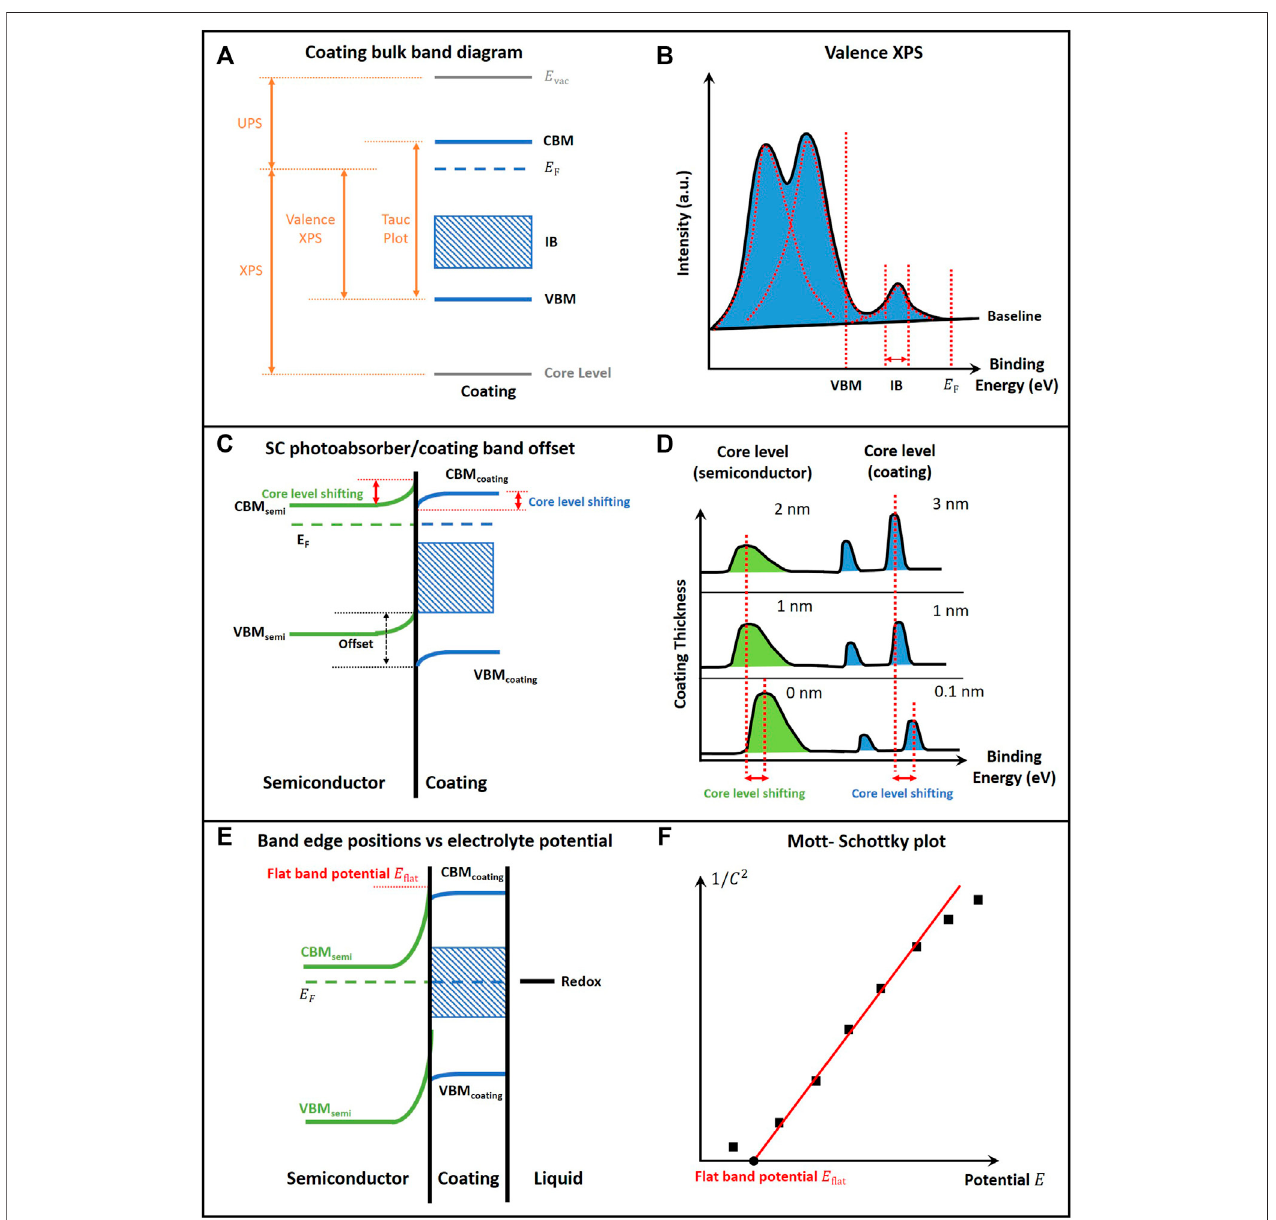
FIGURE 2 | The development of band-energy diagram of semiconductor photoabsorber/coating/(catalyst)/liquid electrolyte. (A) Band-energy diagram for bulk coating; (B) Valence XPS data with peak deconvolution results; (C) Band-energy diagram for semiconductor photoabsorber/coating integrace, which can be obtained from literature report, and the measured position ofthe peak from XPS at the interface (as indicated bythe red arrow); (D) The characteristic XPS core level peak shifting for the semiconductor and the coating; (E) Band-energy diagram for semiconductor photo absorber/coating/(catalyst)/liquid; (F) Mott-Schottky plot, i.e., the reciprocal of the square of capacitance versus the potential between the bulk electrode and the bulk electrolyte.